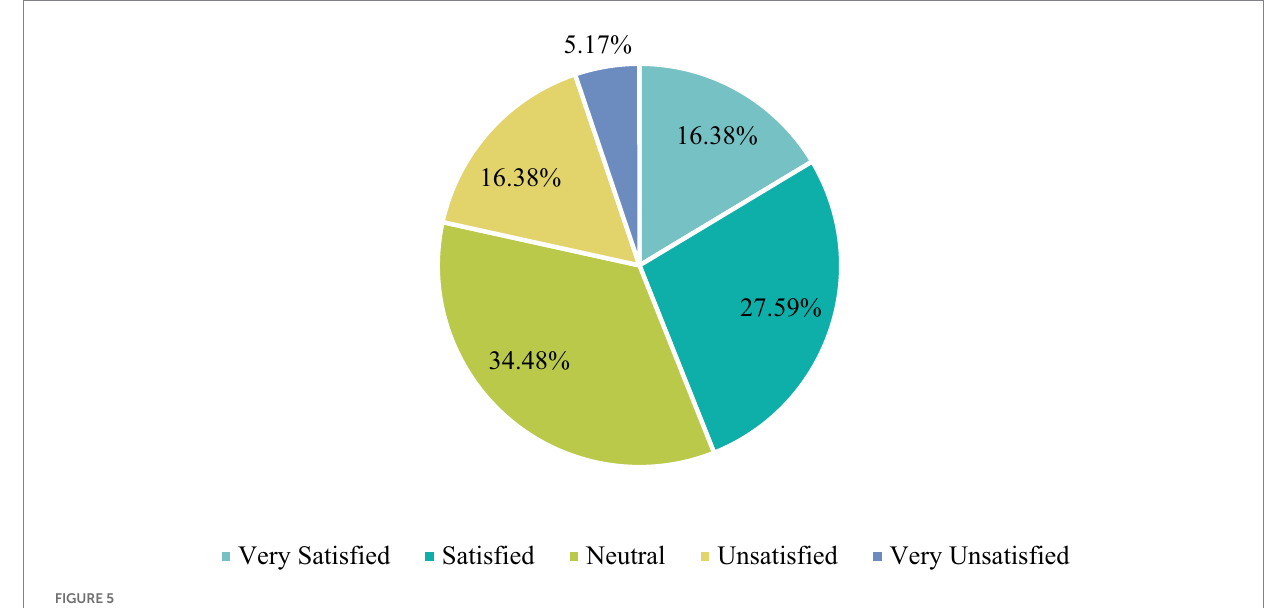
FIGURE 5 Satisfaction with the degree of unimpeded feedback on practical issues in the